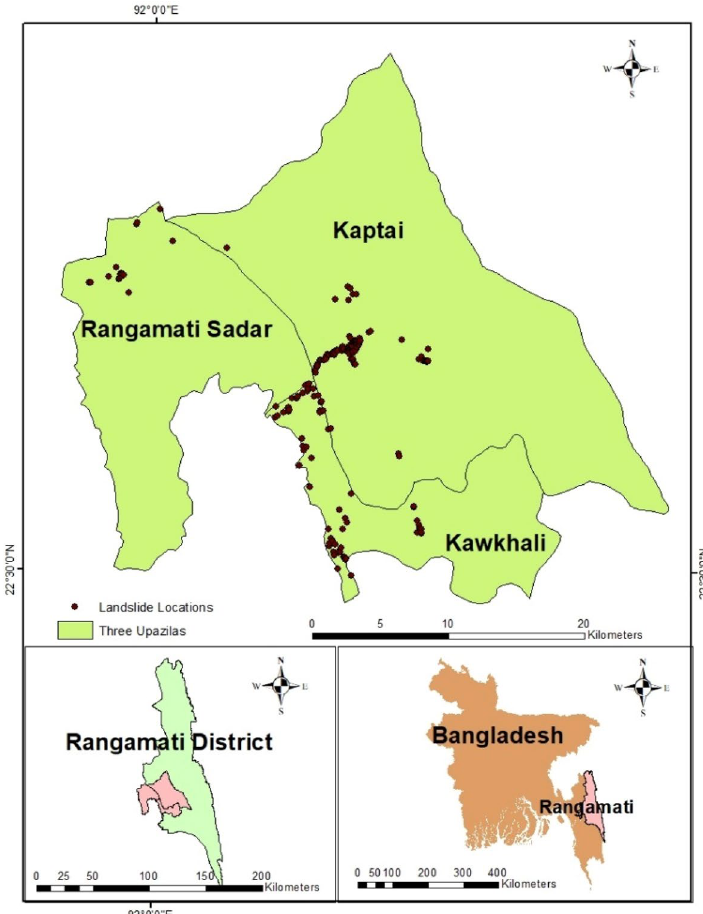
Figure 2. Study area: locations of three Upazilas (Rangamati Sadar Kaptai and